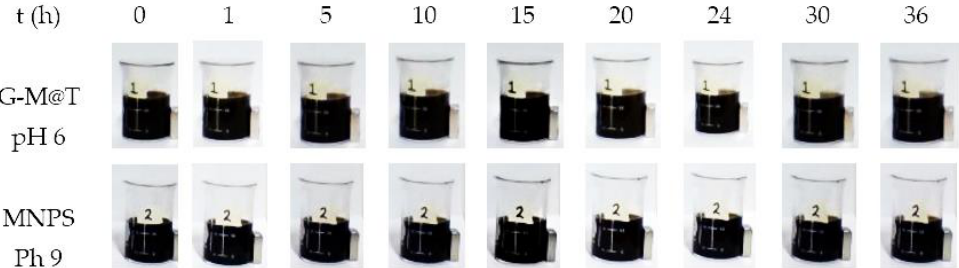
Figure 10. Stability analysis by magnetic precipitation of the nanoparticles synthesized over 36 h.